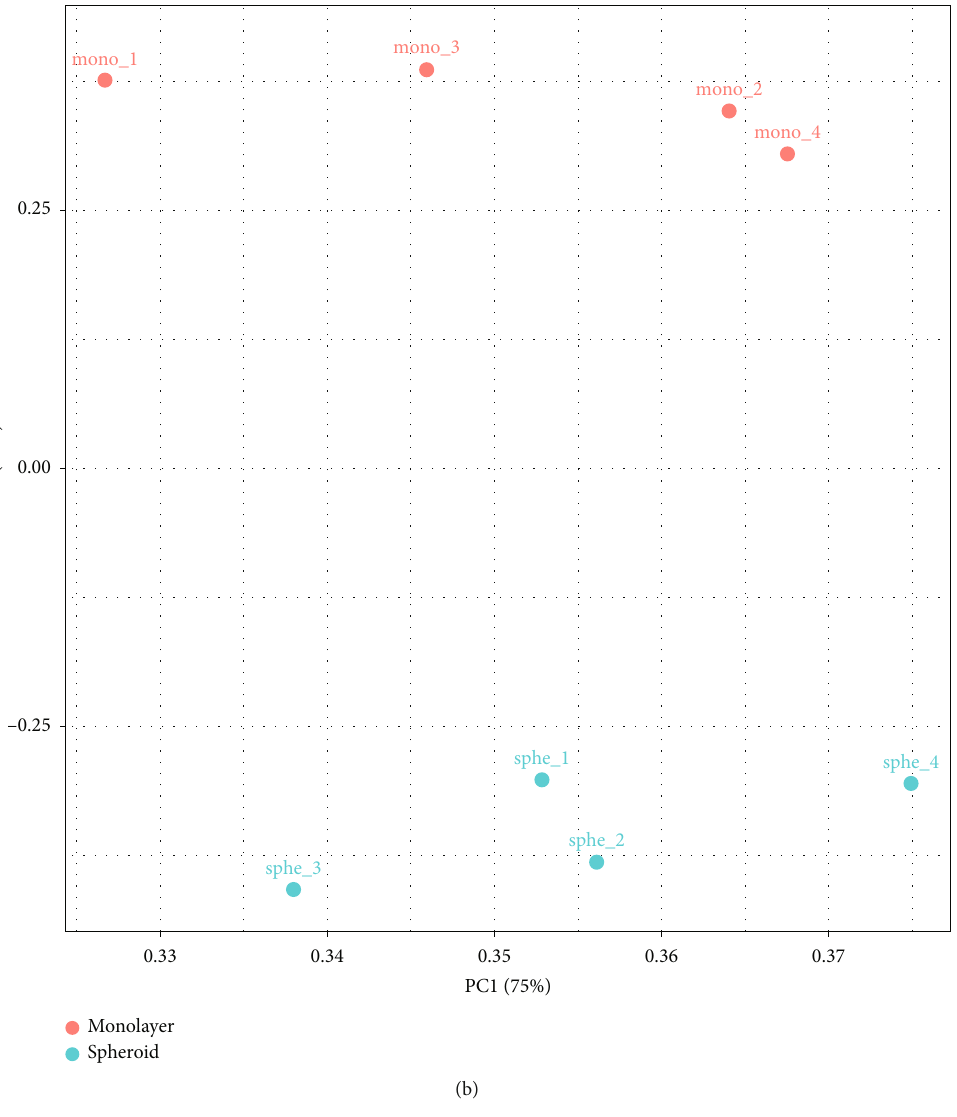
Figure 1: Gene expression pro fi le in each individual sample analyzed by RNA-sequencing. RNA-seq detected 12,137 genes ( FPKM ≥ 1 : 0 ), which were categorized into 3 patterns by hierarchical clustering approach (a; left). Cluster 1, which consists of genes upregulated in monolayer culture, and Cluster 3, which consists of genes upregulated in spheroid culture, were analyzed using DAVID to determine speci fi c enriched GO terms. The fi gure shows the representative signi fi cantly enriched GO terms (Benjamini- Hochberg < 0 : 05 ) (a; right). Principal component analysis (PCA) was performed using 12,137-gene ( FPKM ≥ 1 : 0 ) expression datasets. The PCA plot shows two clearly distinguishable cell culture samples depicted as red (=monolayer) and blue (=spheroid) clusters